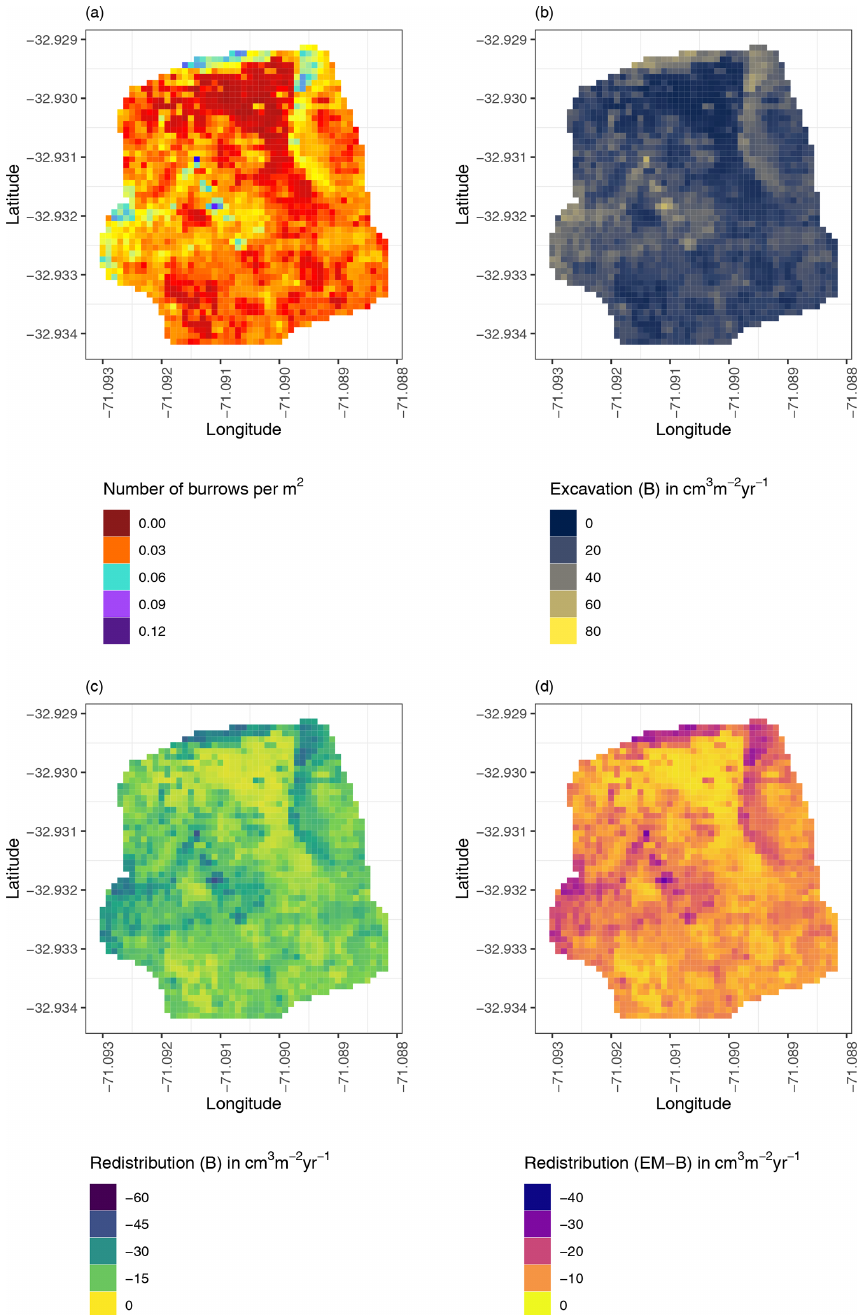
Figure 8. Example of the hillslope-wide volume of redistributed sediment on the south-facing hillslope at La Campana: (a) density of burrows as estimated by Grigusova et al. (2021), (b) volume of the sediment excavated by the animals, (c) volume of the sediment redistributed during rainfall events within burrows, and (d) volume of additionally redistributed sediment during rainfall events due to the presence of the burrows. The values were calculated per burrow, as stated in Sect. 3.7., by subtracting the sediment volume redistributed within burrows from the sediment volume redistributed within the burrow-embedded area and then upscaled. The letters in brackets indicate if the upscaling was conducted using data from burrows or burrow-embedded areas. “ B ” stands for burrow. By “EM- B ”, the redistribution calculated within burrow-embedded areas was subtracted from the redistribution calculated within burrows to obtain the additional volume of redistributed sediment due to the burrows’ presence. Positive values indicate sediment accumulation. Negative values indicate sediment